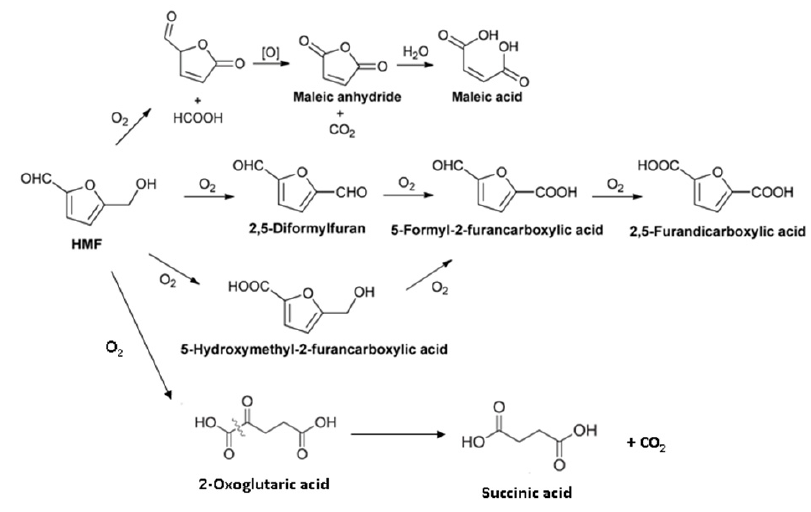
Table 3. The variation of the HMF conversion (C, %) and selectivites (S, %) to the main reaction products in the aqueous oxidation of HMF on the Nb-BEA18 zeolite